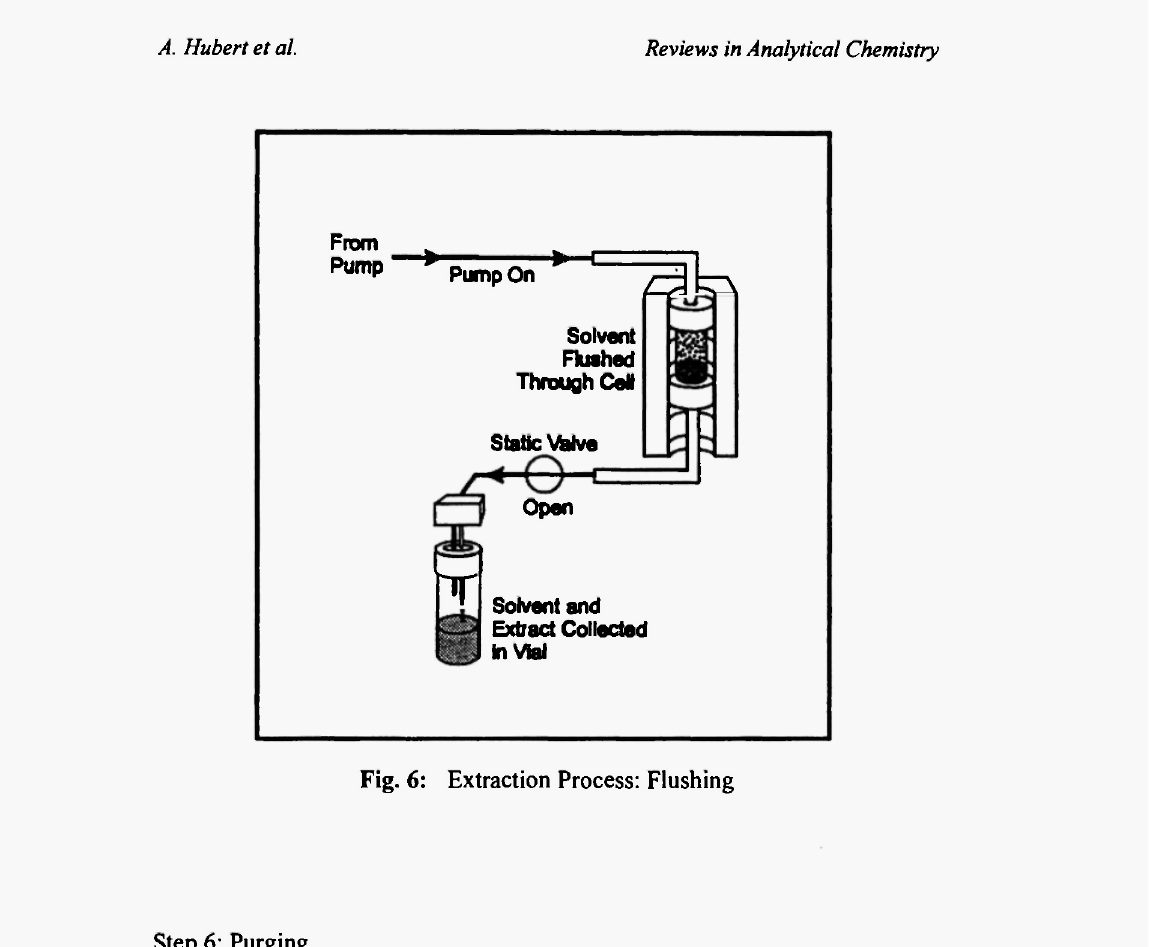
Fig. 6: Extraction Process: